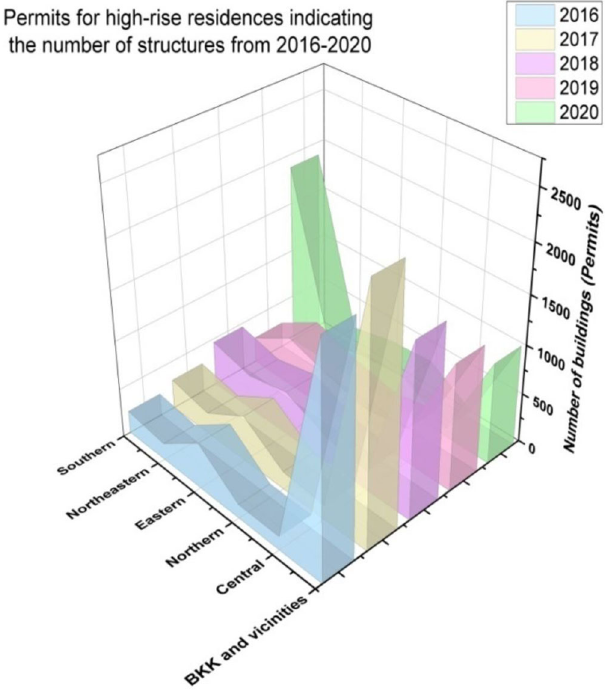
Figure 9. Permits for high-rise residences, indicating the number of structures from 2016 to